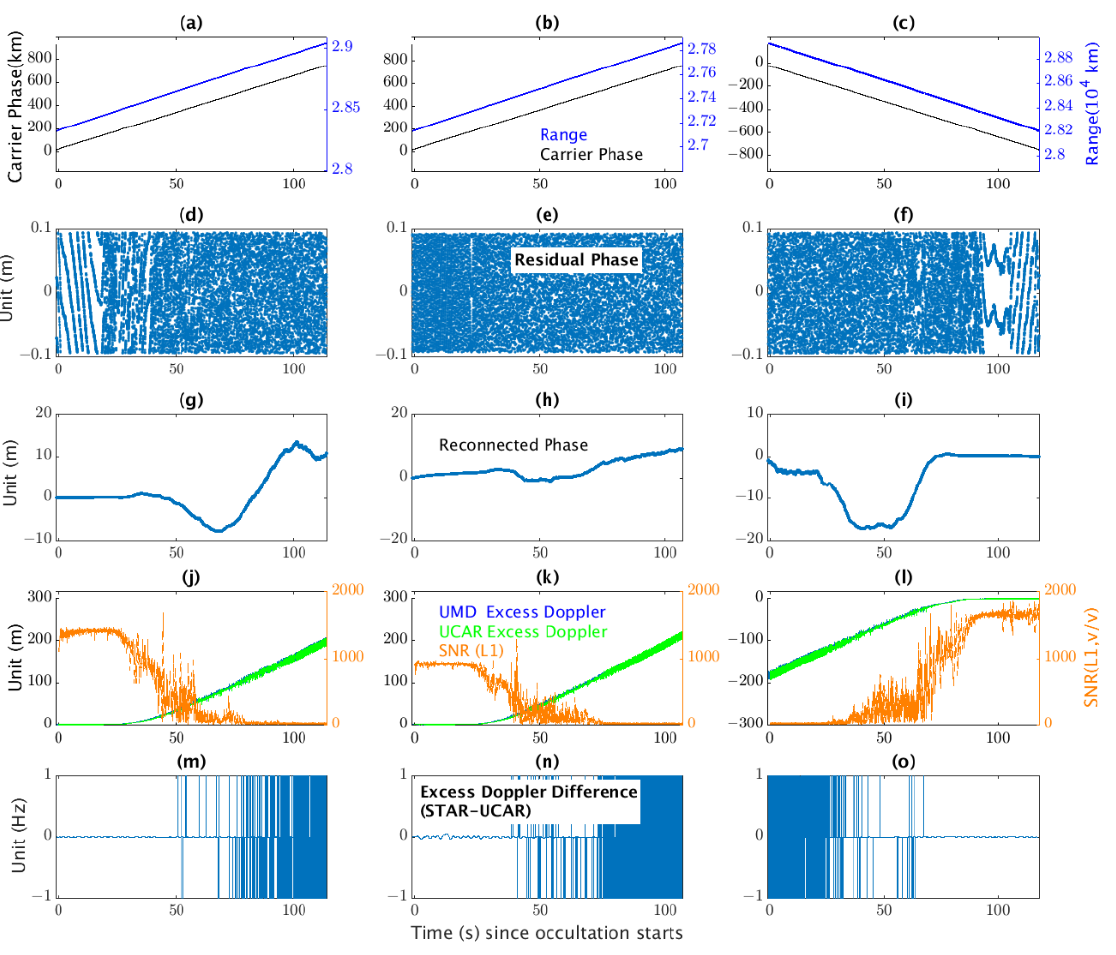
Figure 4. From carrier phase to excess phase conversion with three scenarios of C2E1 (left: GPS setting for G14 at 2019.275 01:43:00 middle: GLONASS setting for R20 at 2019.275 11:31; Right: GPS rising for G09 at 2019.275 11:08). The top row ( a – c ) shows the raw carrier phase (black line) and the calculated range (direct distance) between the GNSS satellite and the LEO satellite (blue line) for three cases. The second row ( d – f ) shows the phase residual (carrier phase minus receiver phase model) before cycle slip removal. The third row ( g – i ) shows the residual excess phase after cycle slip removal. The fourth row ( j – l ) shows the excess Doppler (black line represents STAR results, green lines are UCAR results) and L1 SNR (Unit: v / v ) (orange lines). The fifth row ( m – o ) shows excess Doppler differences.